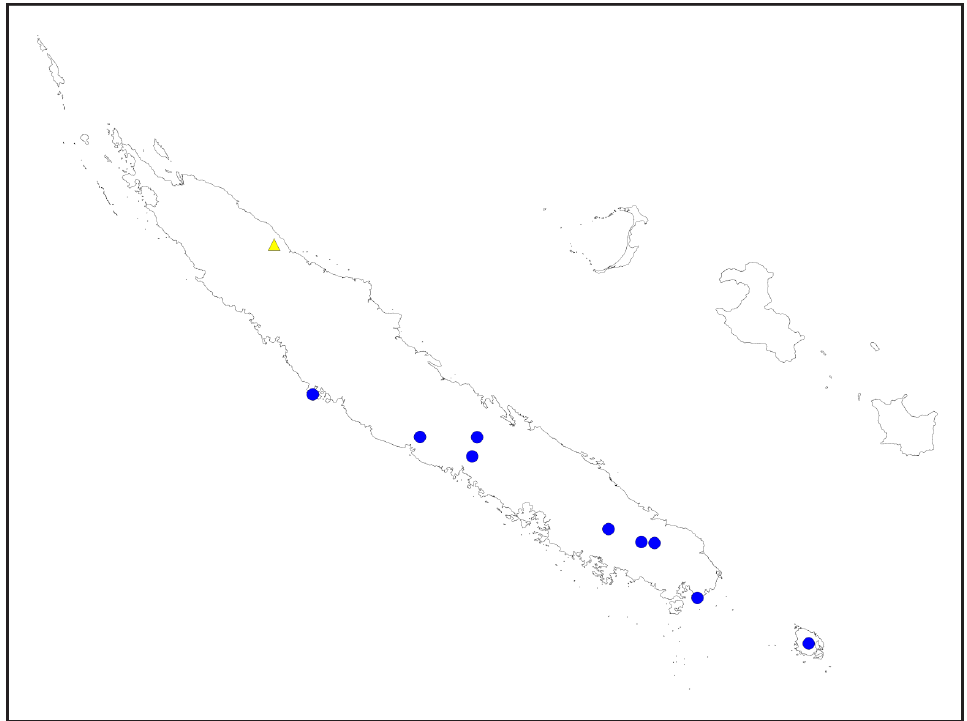
Fig. 10. Recorded localities of C. jacknicholsoni sp. nov. (circle) and C. pantherae sp. nov. (triangle) in New Caledonia and the Loyalty